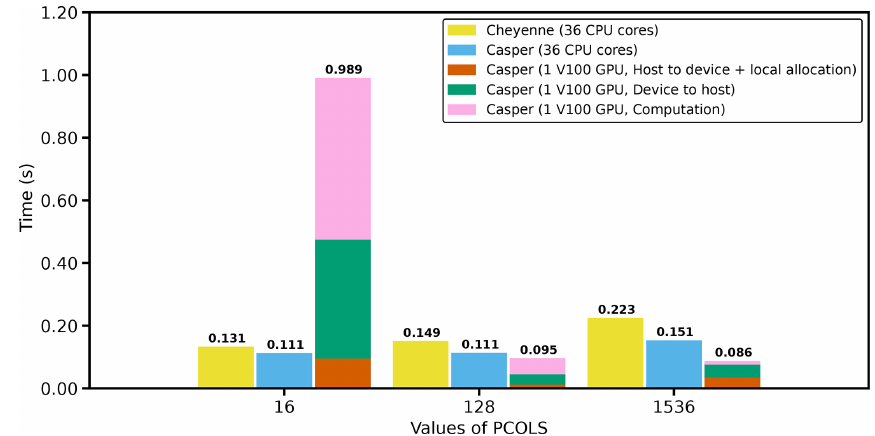
Figure 2. Averaged GPU-enabled MG2 runtime per sub-step for different configurations on the CPU and GPU. The computational time on GPUs is further divided into the time spent copying data from the host to the device, from the device back to host, and time spent in pure computation. Simulations are performed on the Cheyenne and Casper computer systems, with details described in Sect.